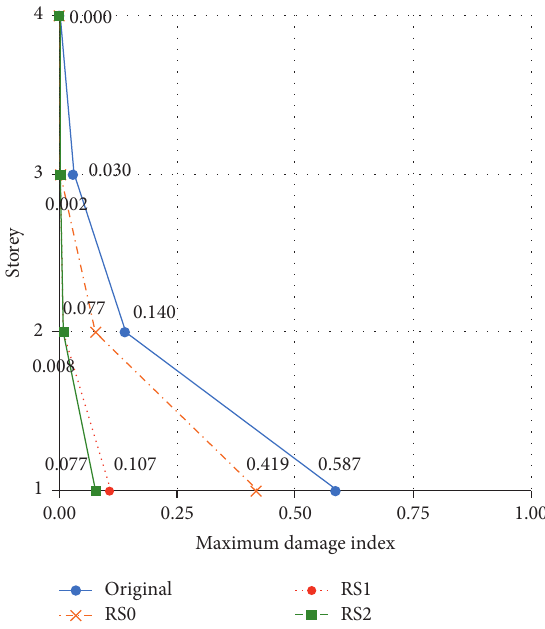
Figure 17: Distribution of storey damage of 4-storey